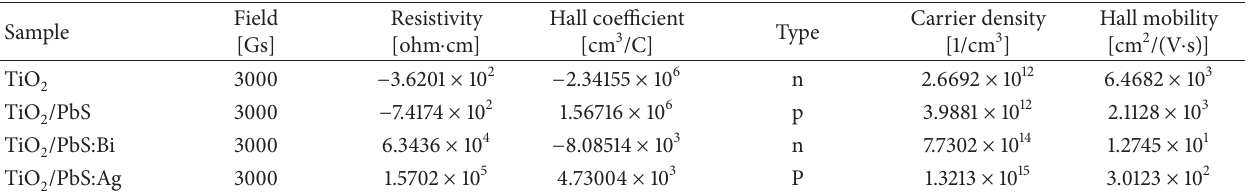
Table 3: Resistivity, Hall coefficient, conductivity type, carrier density, and Hall mobility of PbS:Hg thin film using Hall effect measurement system. The measurement conducted at room temperature under applied field was adjusted from 1 to 5 kG.